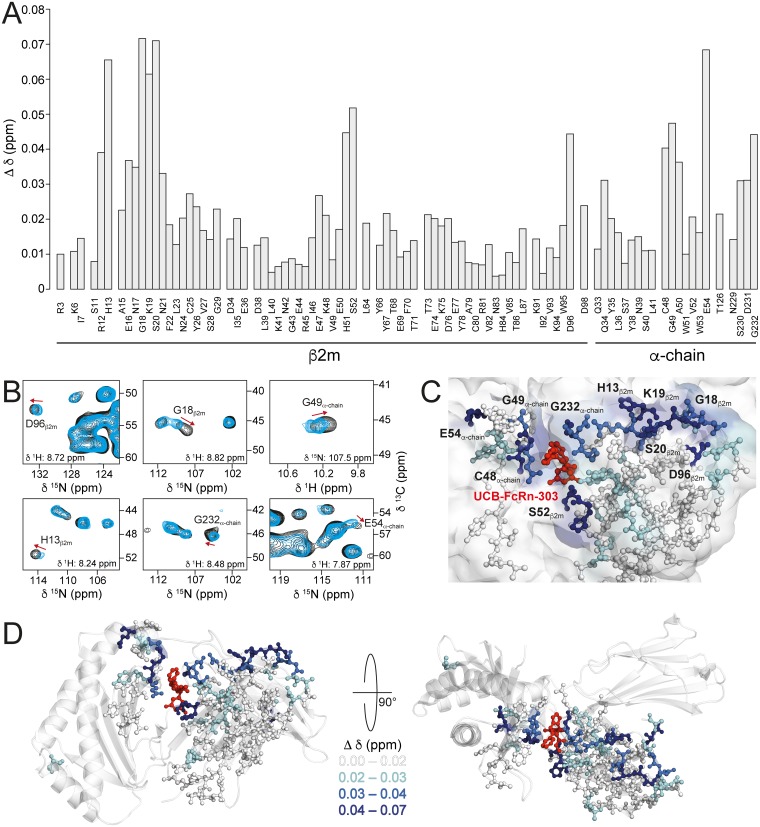
CSPs (Δδ) indicate structural changes in FcRnECD upon ligand binding.(A) CSPs of all assigned amino acids in FcRnECD upon binding to UCB-FcRn-303, calculated with Δδ = MIN{SQRT[(Δδ(1H))2 + (Δδ(13C)/10)2 + (Δδ(15N)/5)2]} (standard deviation = 0.015 ppm). The changes were measured in 3D (H)CANH MAS NMR spectra. (B) CSPs upon UCB-FcRn-303 binding to FcRnECD in 2D planes of 3D (H)CANH spectra with (black) and without (blue) the ligand, both recorded in the presence of 3% DMSO. (C) Structural view of UCB-FcRn-303 (red) bound to FcRnECD with assigned residues in stick representation color-coded according to their CSP (Δδ < 0.02, white; 0.02 < Δδ < 0.03, cyan; 0.03 < Δδ < 0.04, marine; 0.04 < Δδ, dark blue). (D) Structural view of FcRnECD in complex with UCB-FcRn-303 (red) with the same color-coding of changes in chemical-shifts as in (C). All chemical-shifts can be found in S1 Table, S2 Data, and in the BMRB (accession number 27437). BMRB, Biological Magnetic Resonance Data Bank; CSP, chemical-shift perturbation; FcRn, neonatal Fc receptor; FcRnECD, extracellular domain of the neonatal Fc receptor.